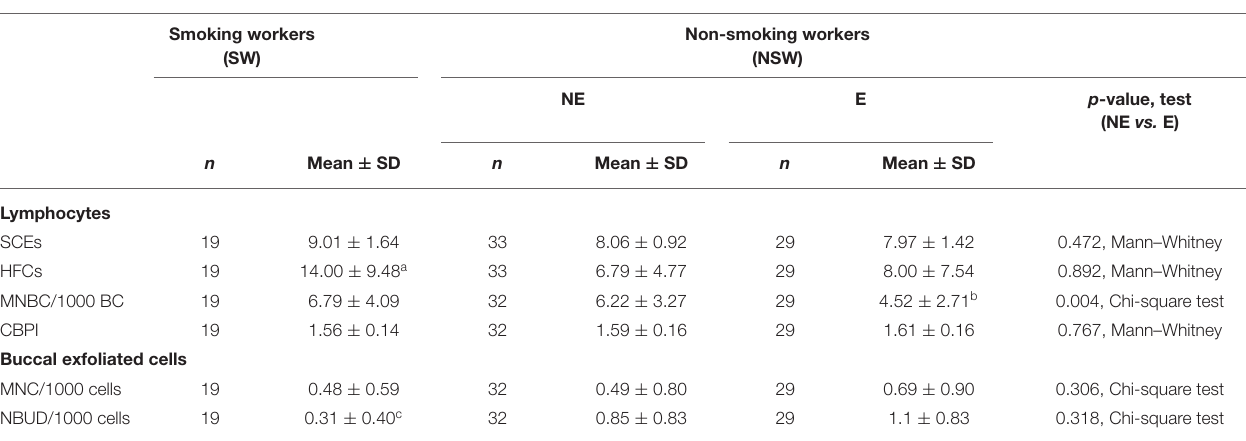
TABLE 2 | Results of the cytogenetic effect